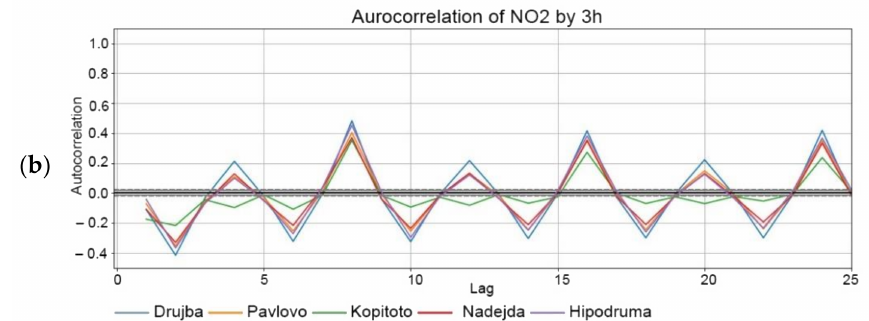
Figure 10. The signal for the different stations corresponding to NO 2 for granularity 3 h with lag difference 1 ( a ) and its autocorrelation ( b ).